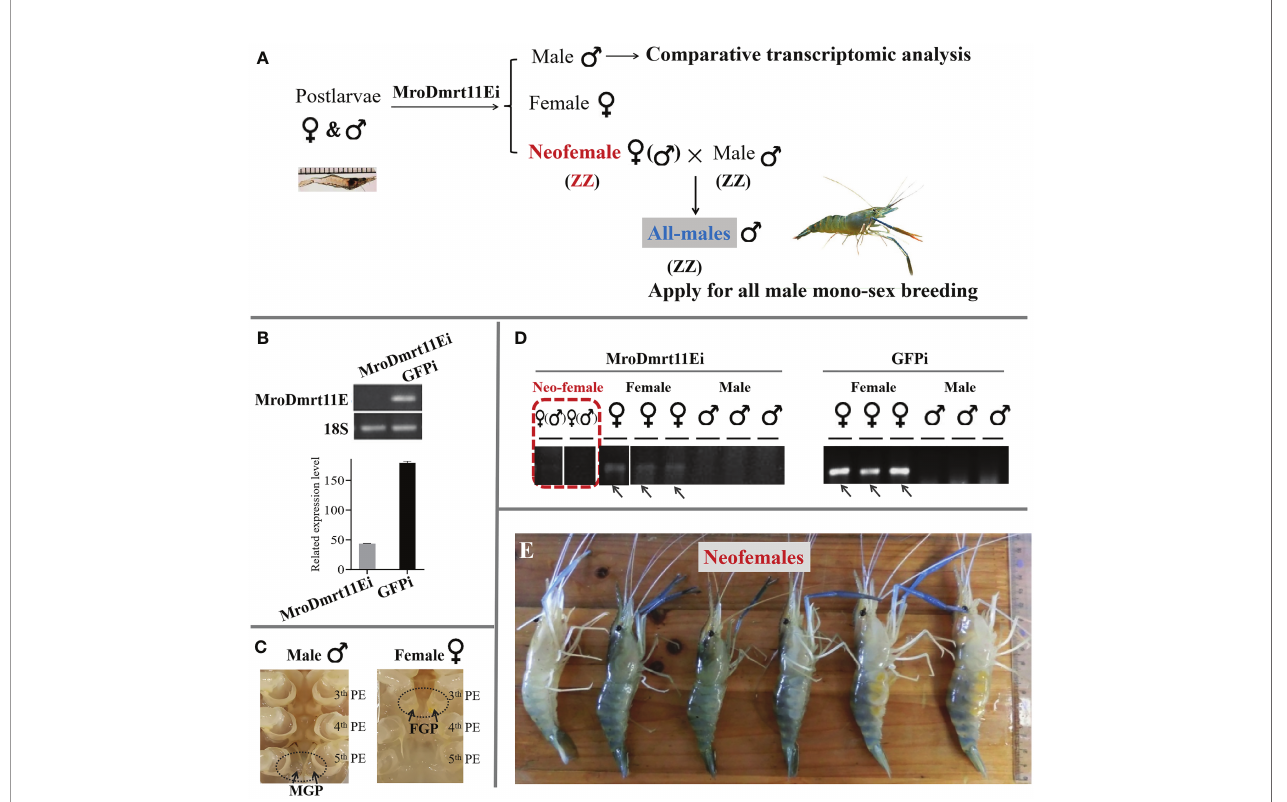
FIGURE 1 | In vivo knockdown of MroDmrt11E by RNAi in postlarvae. (A) The diagrammatic sketch of in vivo knockdown of MroDmrt11E by RNAi in postlarvae. MroDmrt11E dsRNA injection was performed in postlarvae, and the gene silencing lasted for 3 months. (B) Detection of the relative MroDmrt11E mRNA level in RNAi induced and the control group. (C) The sex identi fi cation of differentiated male and female prawn by the appearance of sexual characteristics in M. rosenbergii. There was a pair of male genital pores located at the coxopodite of the fi fth pereiopods in males, but a pair of female genital pores located at the coxopodite of the third pereiopods in females as well as neo-females. MGP, male genital pores; PE, pereiopods. (D) The gender of individuals was identi fi ed using sex molecular markers in both MroDmrt11E RNAi and the control group. The female-speci fi c sex band indicates female genotype. The female-speci fi c sex bands are indicated by the gray arrows in females. The representative neo-female prawn are shown in a red broken line frame. (E) The neo-female prawn with female appearance features. The MroDmrt11E -silenced genetic males (neo-females) were raised to maturity and induced appearance features of females. Some neo-females spawned and incubated the eggs/embryos in their brood chambers, located ventrally on their